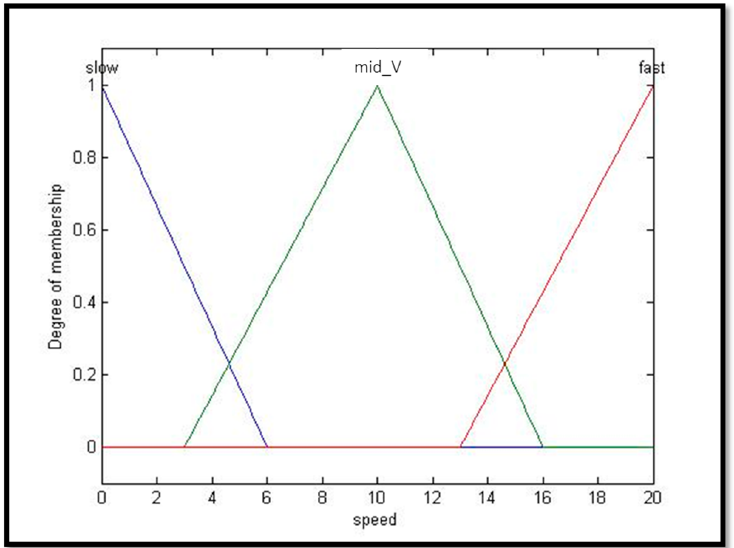
Figure 7. Membership function of horizontal speed.